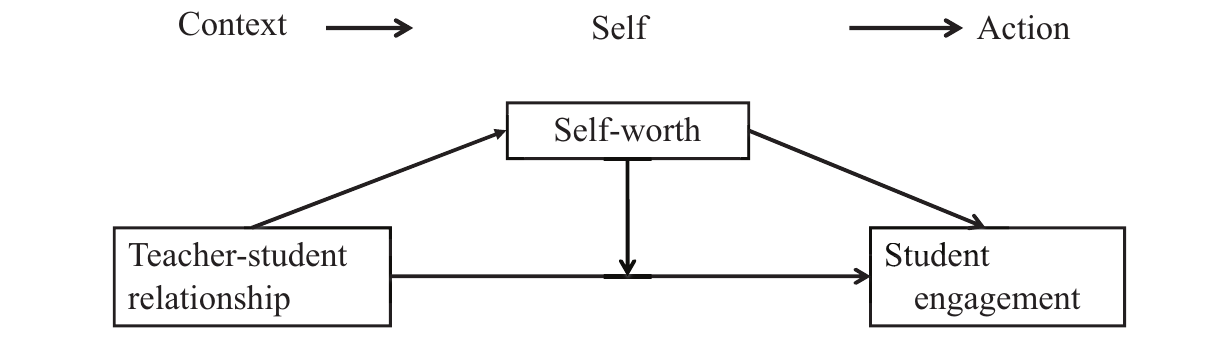
FIGURE 1 | Research model.